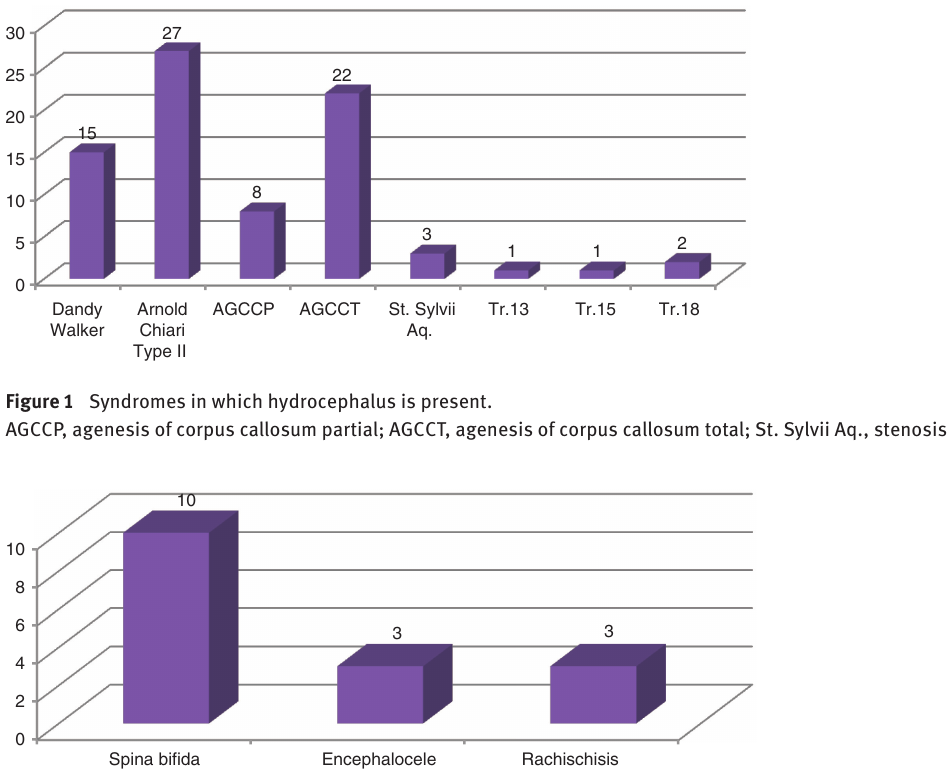
Figure 2 Associations of the Arnold-Chiari type II